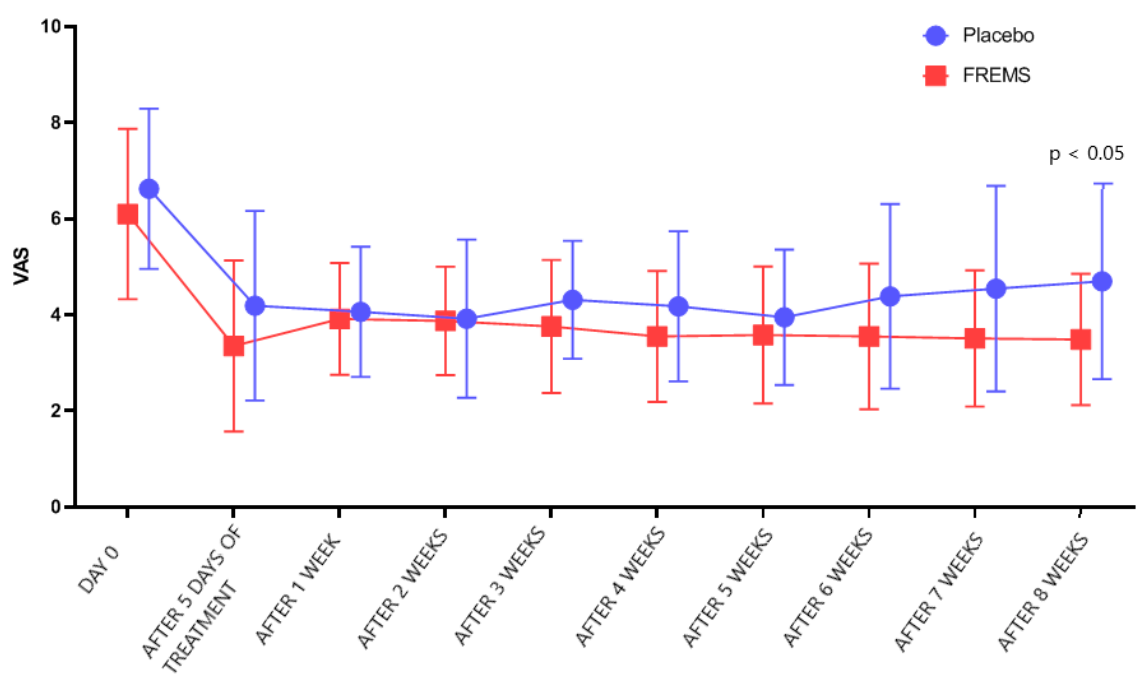
Figure 4. The trend of changes in VAS during the study on sham-FREMS and FREMS groups.